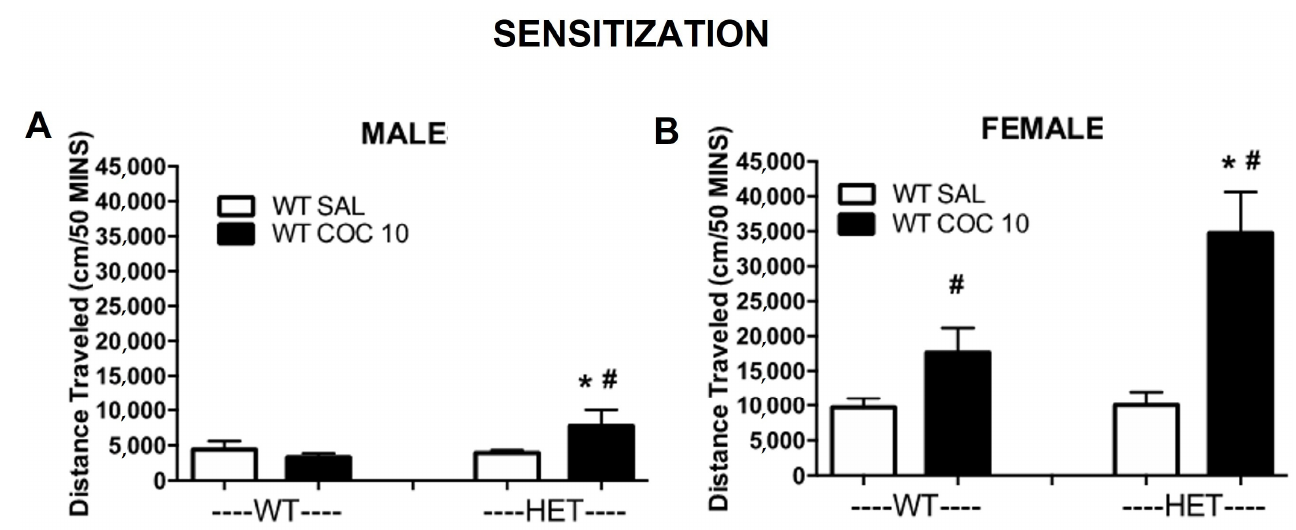
Figure 6. Effect of cocaine (sensitization challenge, 10 mg/kg) on cumulative distance traveled in DAT mutant rats. Cumulative time (30 min after acute treatment) is represented across conditions (SAL = saline, COC 10= 10 mg/kg cocaine) in males ( A ) and females ( B ). # p < 0.05 compared to SAL; * p < 0.05 compared to WT. Mean ± SEM. (males: WT N = 15, HET N = 36; females: WT N = 24, HET N = 24).